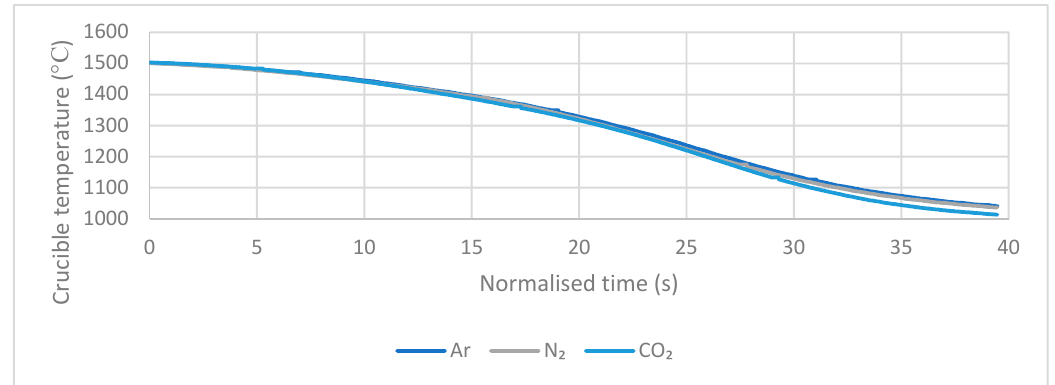
Figure 2. Temperature curves of the crucible during each test to ensure consistent conditions for each test. Normalised time refers to 0 s, being when the CLSM power was switched off.